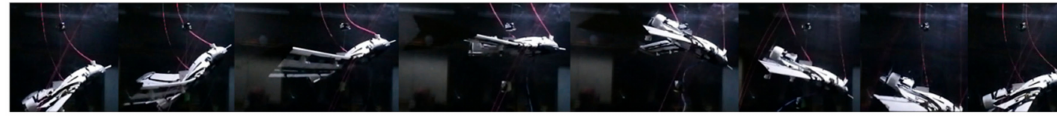
Figure 17. BFF phenomenon observed during wind tunnel